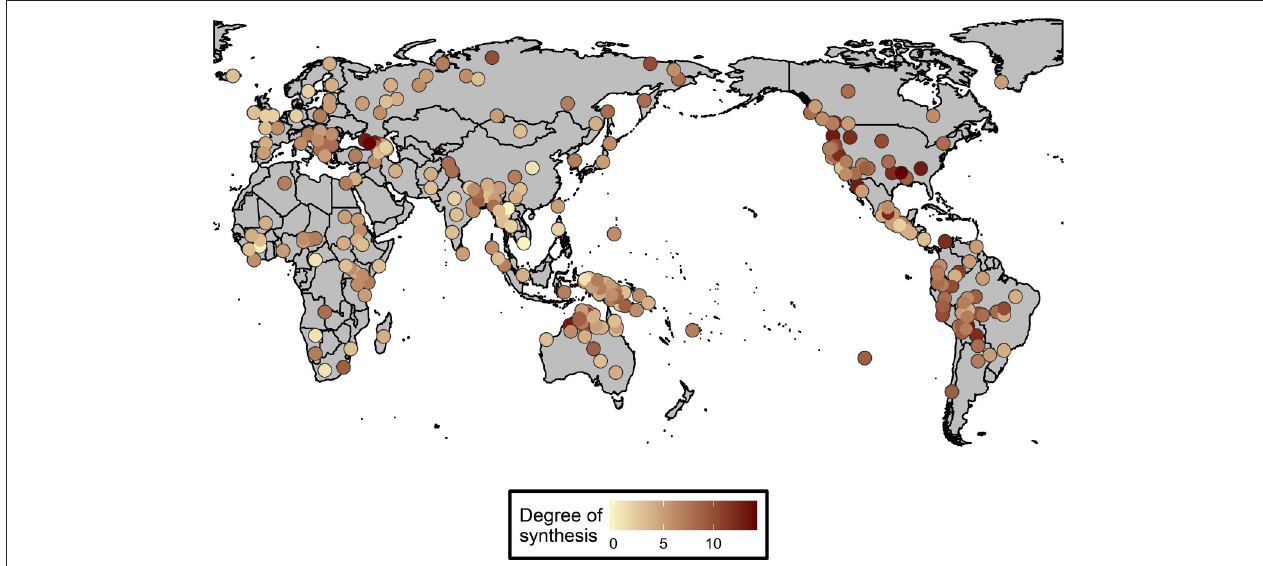
FIGURE 3 | Degree of inflectional synthesis and its areal distribution on a world map.